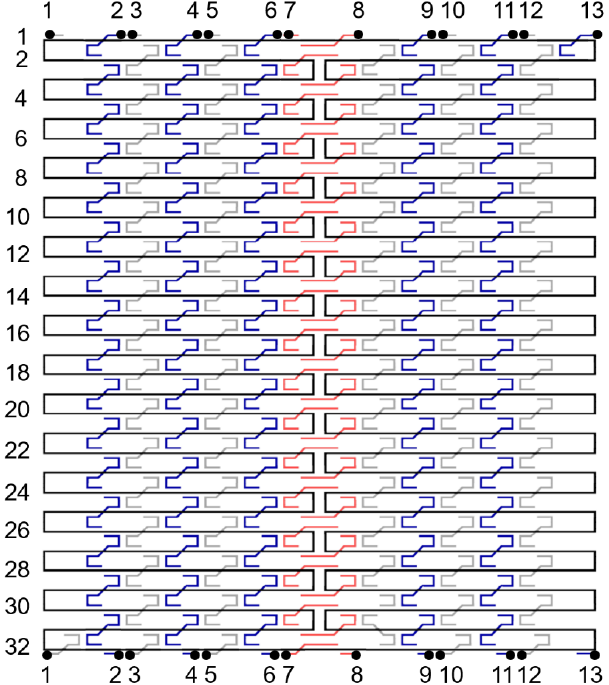
Figure 1. Folding path diagram of a DNA origami tile. Black line denotes the scaffold strand, which routes clockwise (5’ to 3’ end). Blue, gray, and red lines represent staples. The color marks different shape and directions. Blue and gray staples have the same shape but opposite directions: blue goes down while gray goes up from 5’ to 3’ end. The red staples secure the scaffold in the middle of the origami and thus have a different shape compared with blue and gray. A typical staple length is 32 nt. The dsDNA bundles are numbered 1 through 32, as noted on the left. Note that a total of 13 gray and blue staples were used to seal the upper and lower edges to form a cyclized tube in the experiment. The 13 pairs of the black dots indicate the cut sites of the linker staples. This design was used in the MD